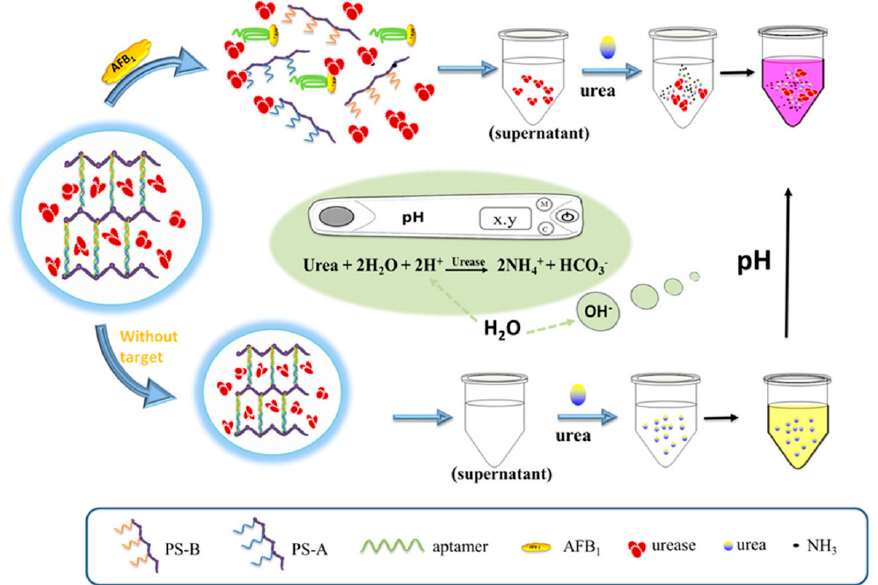
Figure 7. Schematic illustration of the portable device for the detection of AFB 1 based on the DNA hydrogels and pH meter. Reproduced with permission from Mengmeng Zhao, Talanta; published by Elsevier, 2017.